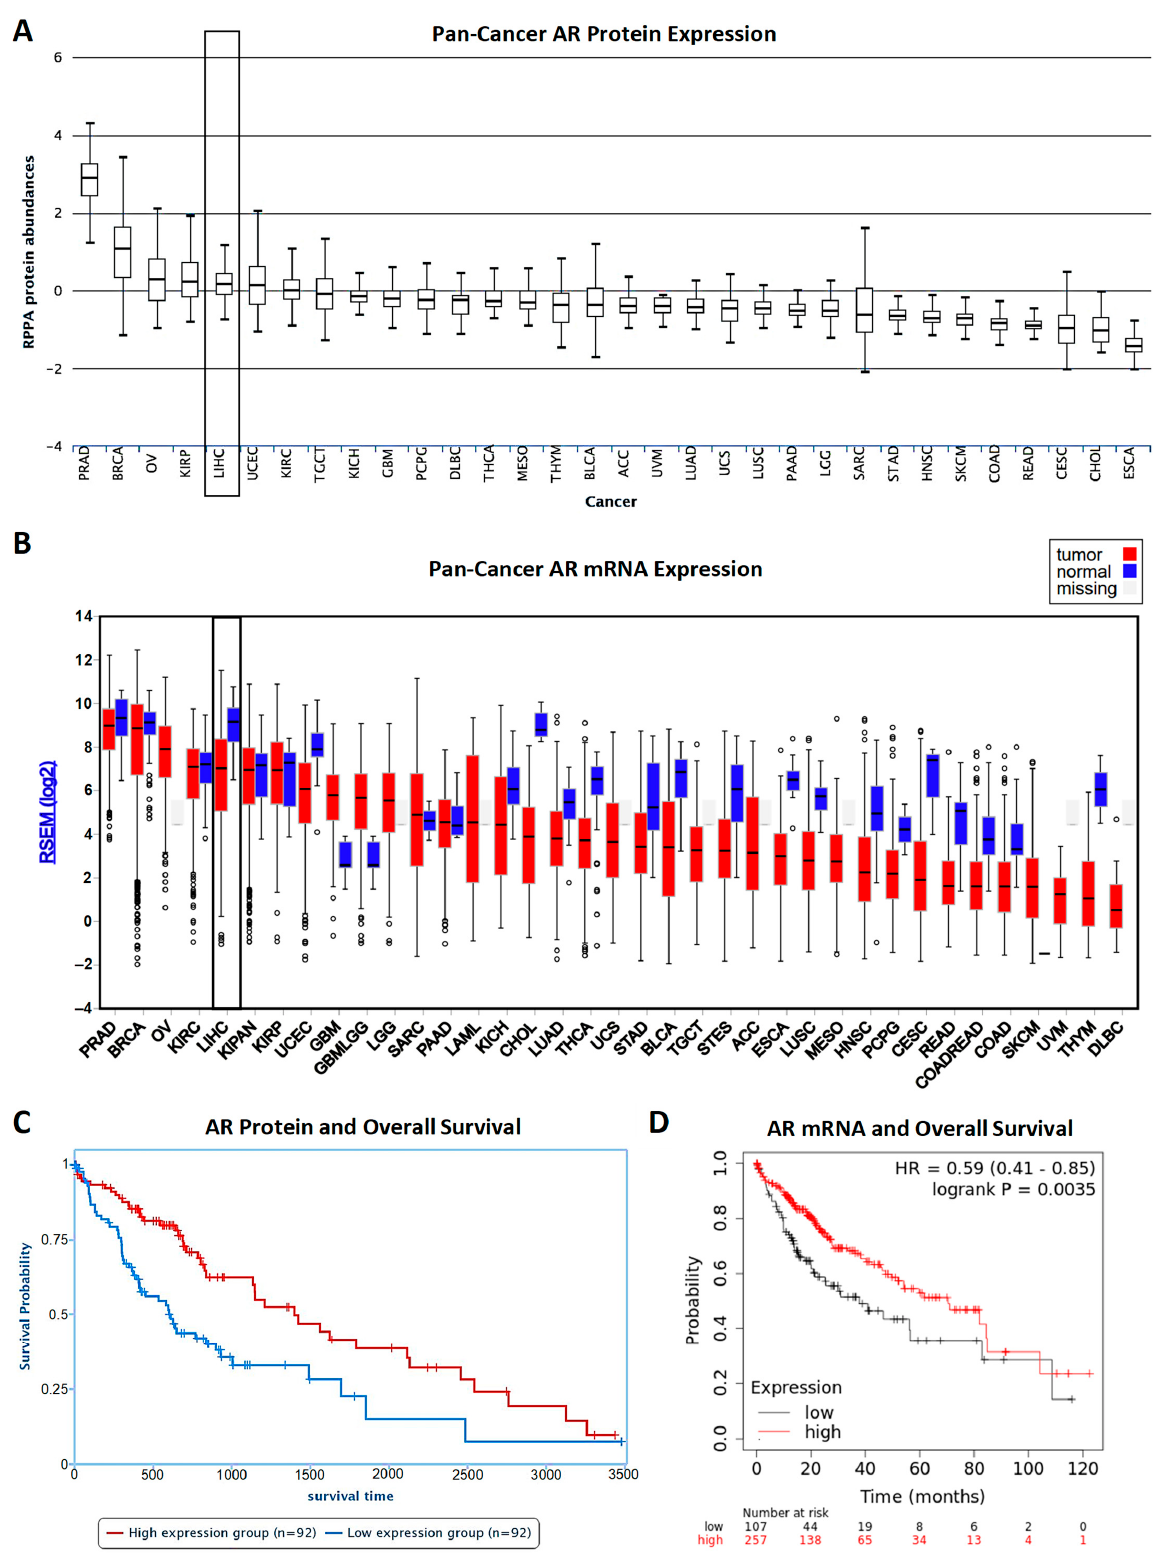
Figure 2. Plots showing AR mRNA and protein expression in HCC. ( A ) Figure charting AR protein expression from highest to lowest across cancer types from the TCGA as measured by reverse-phase protein assay on TCGA tissue samples using AR antibody (ab52615 by Abcam). Data encompass 184 liver cancer patients. LIHC (Liver Hepatocellular Carcinoma) data are highlighted. Figure gener- ated in The Cancer Protein Atlas (TCPA) (https://www.tcpaportal.org/) [15,16]. ( B )